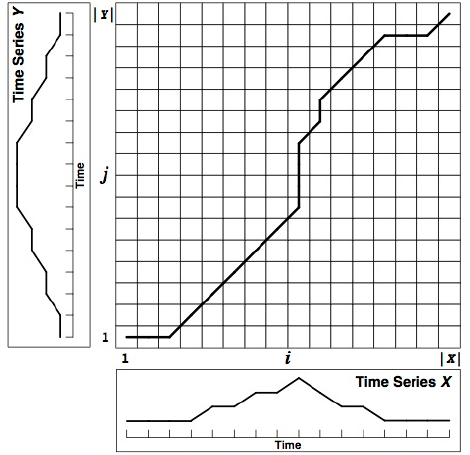
Figure 3. Diagram of dynamic time warping.